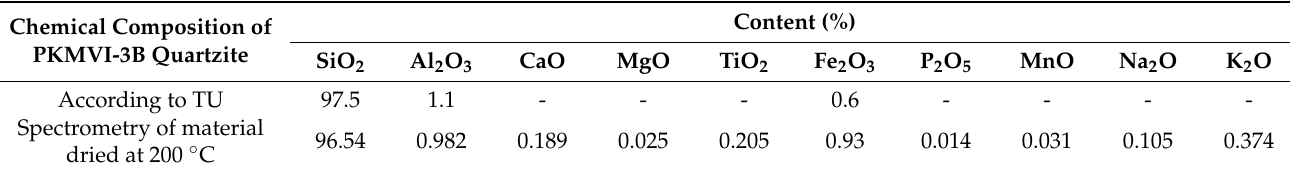
Table 1. Chemical composition of PKMVI-3B